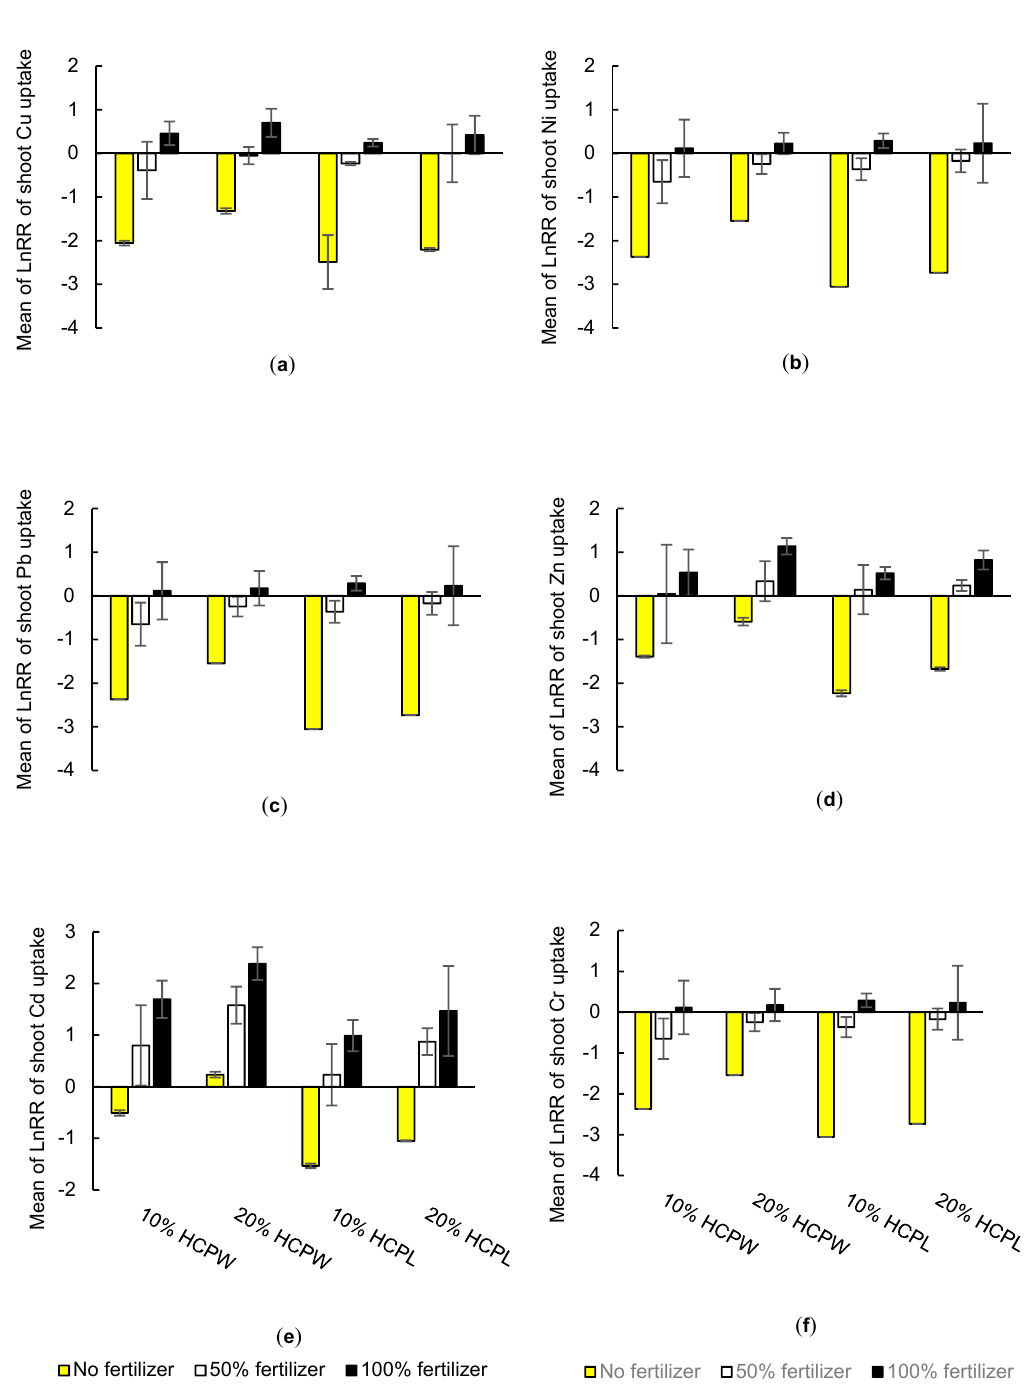
Figure 4. Mean ( ± 95 CI, n = 3) natural logarithmic response ratios (standardized with the untreated fully-fertilized control) of shoot Cu ( a ), Ni ( b ), Pb ( c ), Zn ( d ), Cd ( e ) and Cr ( f ) uptake of pine tree seedlings grown in peat mixed with 10% and 20% (v / v) hydrochar powder (HCPW) and hydrochar pellet (HCPL) in unfertilized (yellow bars), half (open bars) and full fertilized (black bars) conditions. E ff ects of hydrochar type and application rate were considered significant, relative to controls receiving 100% fertilizer, when 95% CI did not overlap with zero in each nutritional